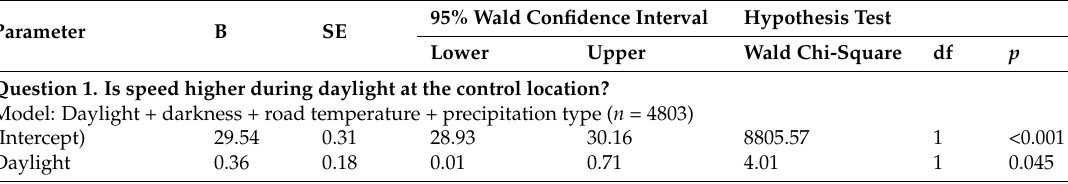
Table 3. Results for the parameter estimates from the generalised linear models for questions 1–4. Significant variables selected are included in the table. For main results of the model testing of influence of the independent variables on the dependent variable (vehicle speed), see Table 2. For questions 2 and 4, effects of individual humps are shown. SE = standard error, p = significance level, df = degrees of freedom.